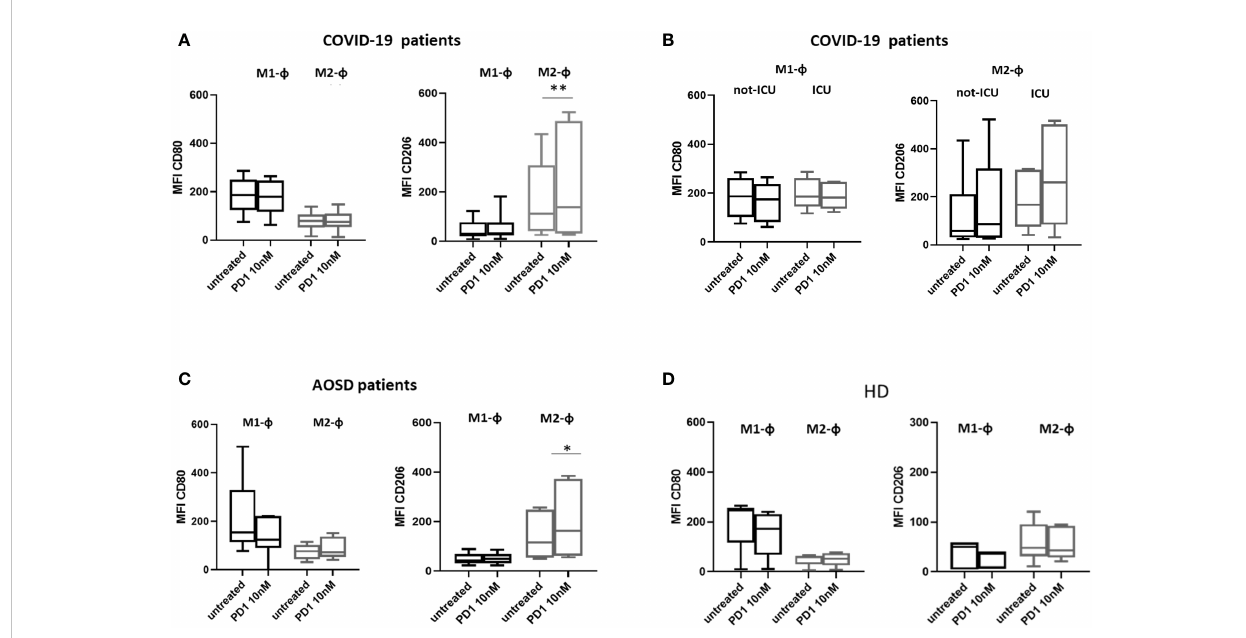
FIGURE 3 Effect of PD1 on polarization of macrophages from HDs, COVID-19 and AOSD patients. Expression of surface markers by fl ow cytometry on M1 and M2 macrophages from COVID-19 patients (A) , not-ICU and ICU COVID-19 patients (B) , AOSD patients (C) and HDs (D) after treatment with PD1. Data are represented as box plots displaying medians, 25th and 75th percentiles as boxes, and 10th and 90th percentiles as whiskers, and reported as Mean fl uorescent intensity (MFI). M2 macrophages from COVID-19 patients, untreated vs PD1 **p = 0.009; M2 macrophages from AOSD patients, untreated vs PD1 *p =0.02. ICU, intensive care